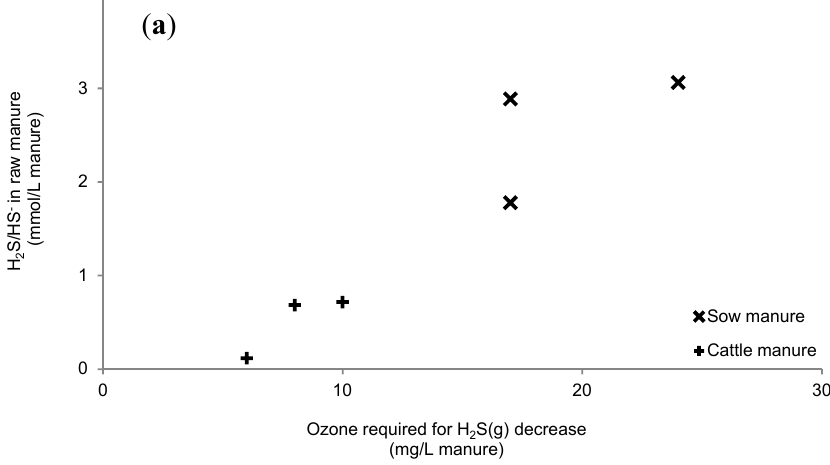
Figure 5. Relationship between ozone additions required to lower the gaseous H S/HS − concentration in the raw manure, and ( b ) with the concentration ( a ) with total H 2 total chemical oxygen demand (COD) of the raw